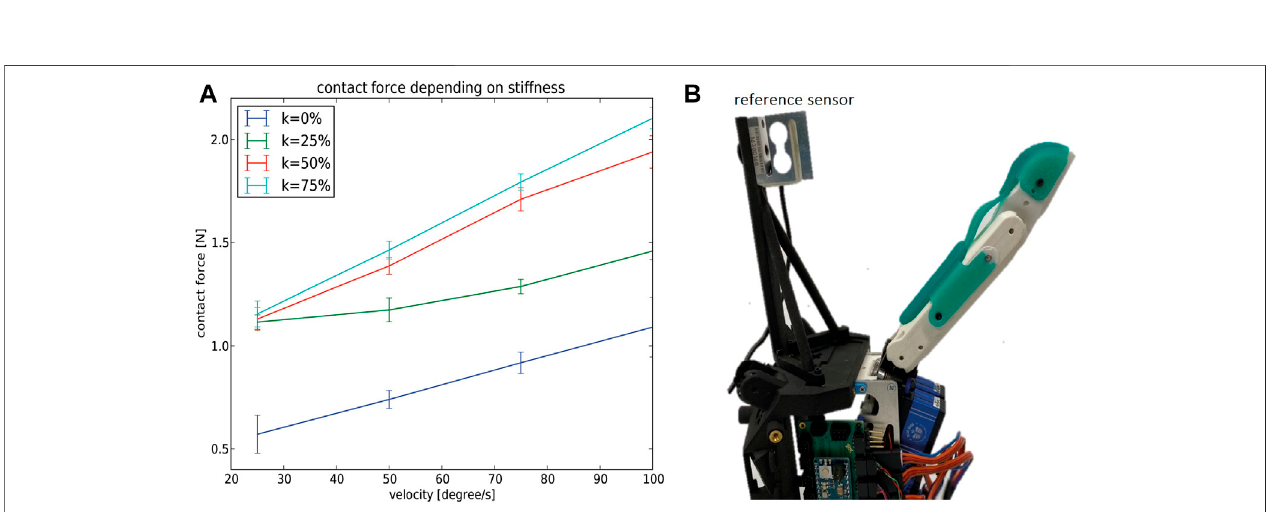
Frontiers in Robotics and AI |